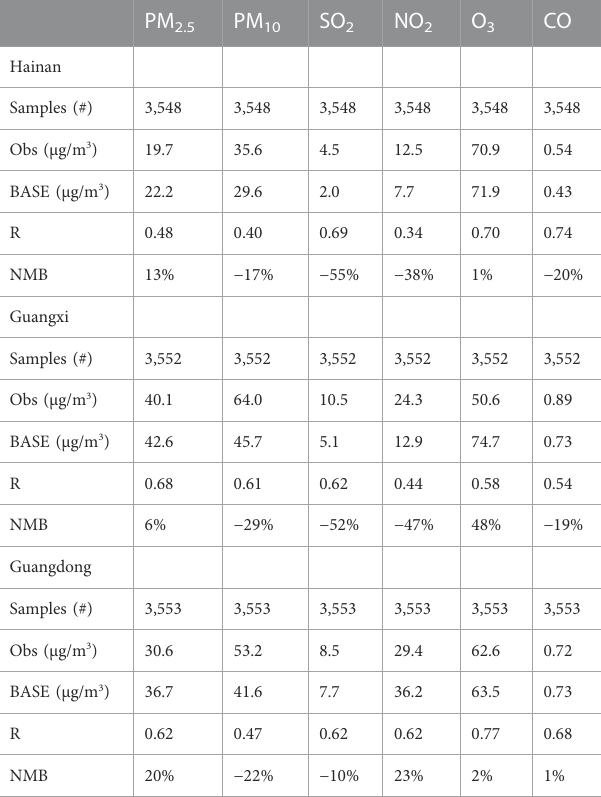
TABLE 2 Comparison statistics for modeled hourly pollutant concentrations at CNEMCsitesinHainan,Guangxi,andGuangdongprovinces.Meanobservation (Obs), mean simulation result of BASE, correlation coef fi cients (R), and normalized mean bias (NMB) are listed. PM